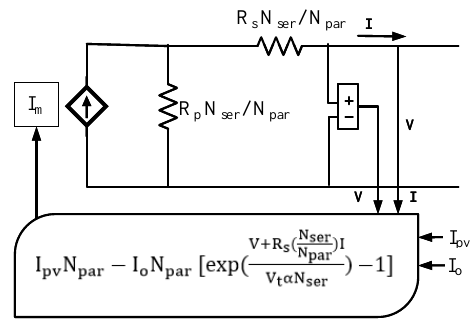
Figure 1. Circuit diagram of a photovoltaic (PV) array model [18].